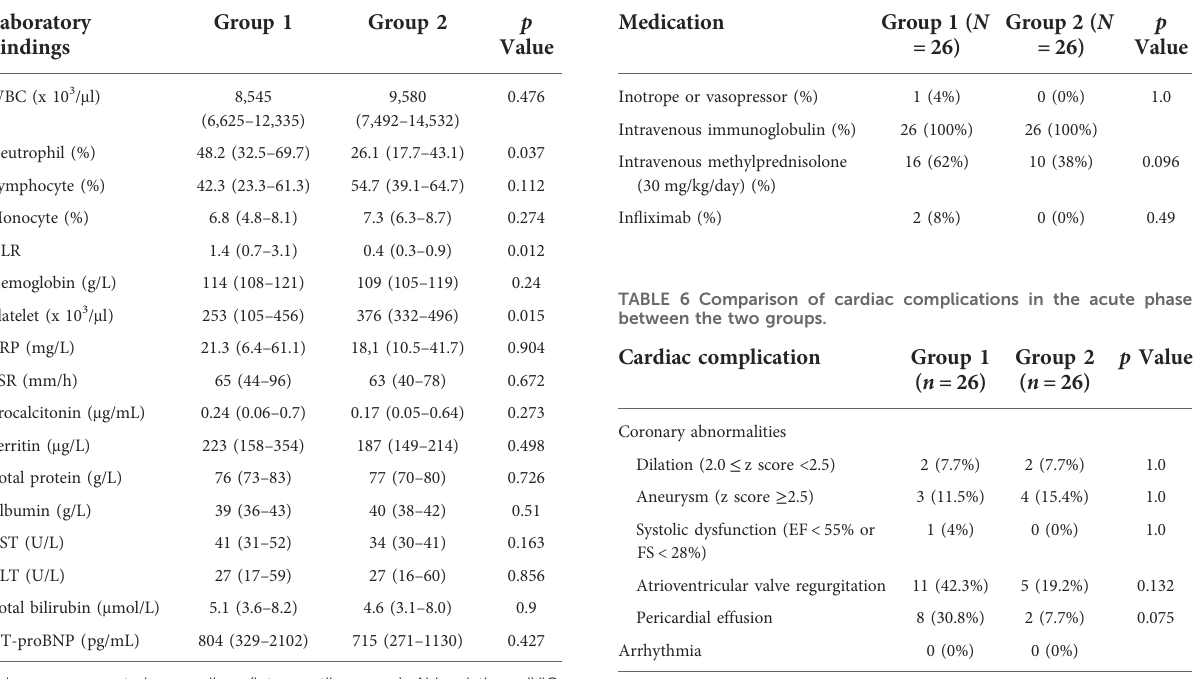
TABLE 4 Comparison of laboratory fi ndings of two groups 24 h after IVIG infusion.